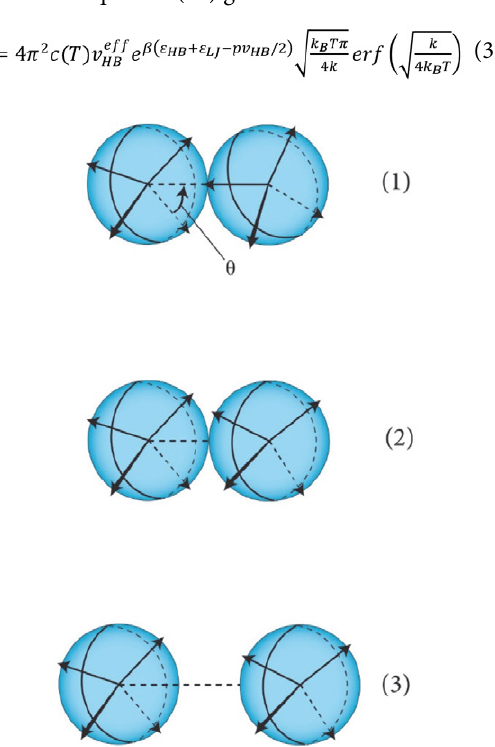
Figure 6: The three model states: (1) hydrogen bonded, (2) vdW bonded, and (3) nonbonded in